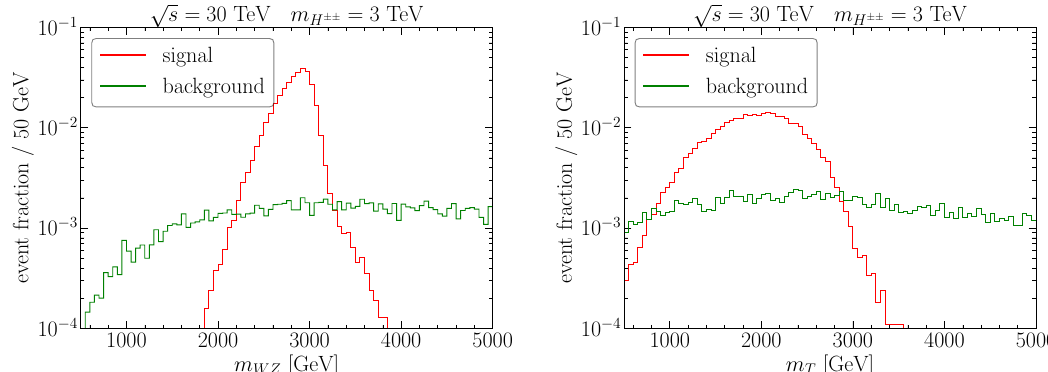
Figure 18 . The invariant mass of reconstructed W and Z bosons (left) and the transverse mass of the muons and missing energy from the same-sign W bosons (right) in the signal H ±± H ∓ → WWWZ → µ µ ν µ ν µ JJ and SM backgrounds.